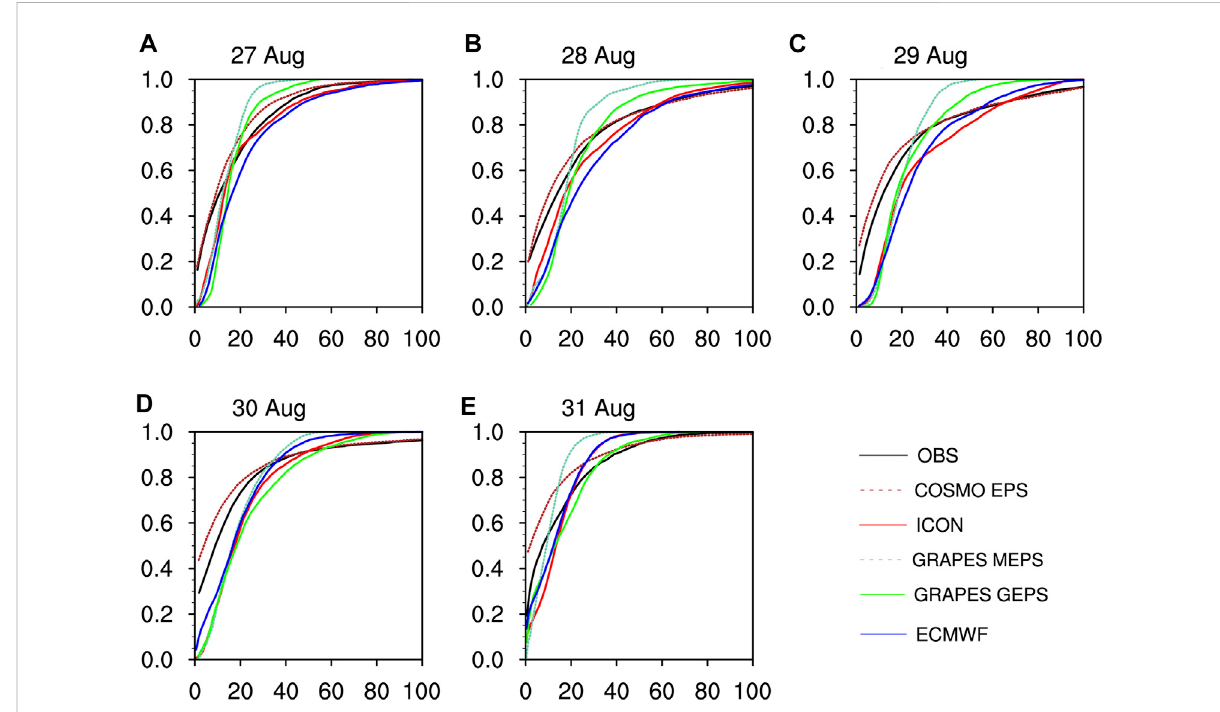
FIGURE 3 Cumulative distribution functions (CDF) of daily accumulated precipitation for the observations (the black solid line) and all model predictions (the colored lines) used in this study. The horizontal axis represents the precipitation amount. The dashed lines represent the results of the regional models (i.e., COSMO EPS and GRAPES MEPS) and the colored solid lines represent the global